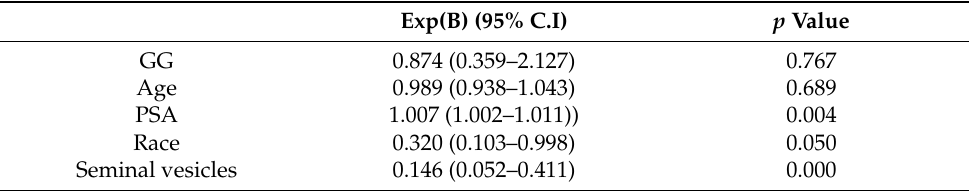
Table 2. Logistic regression of variables that predict for